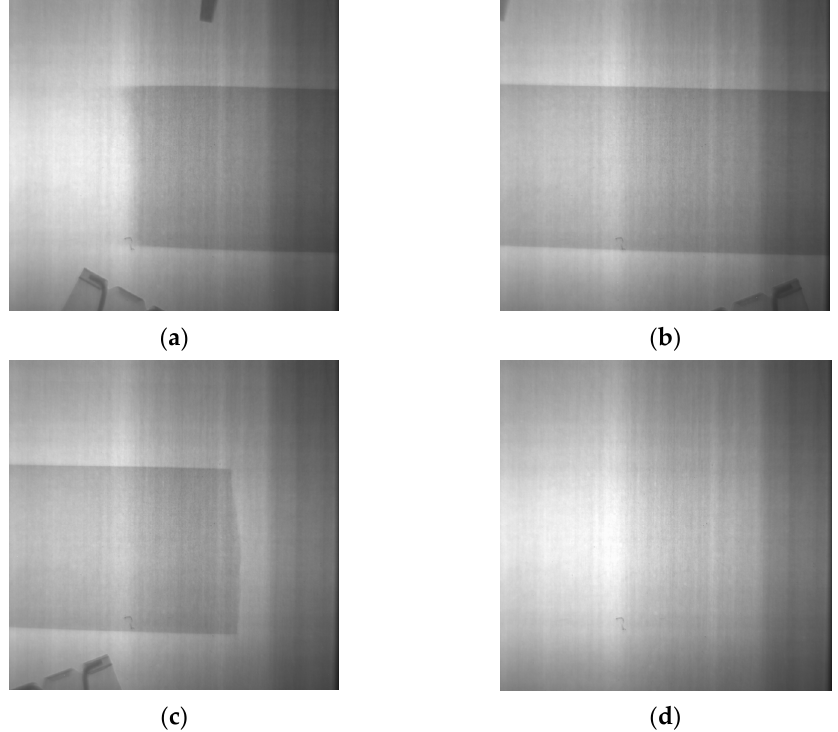
Figure 3. Results of neutron imaging: ( a ) fuel plate neutron image (left); ( b ) fuel plate neutron image (middle); ( c ) fuel plate neutron image (right); ( d ) background diagram.